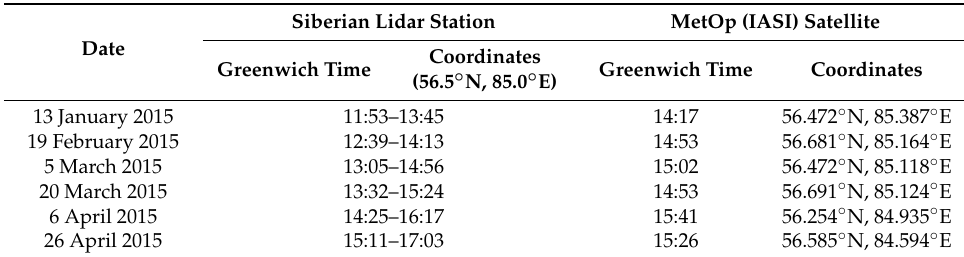
Figure 4. Mean error of ozone profile retrieval over 2015. Figure 5 exemplifies the comparison of lidar and satellite vertical profiles of ozone measured on 26 April 2015; the VDO profiles are compared with the Krueger model [24].